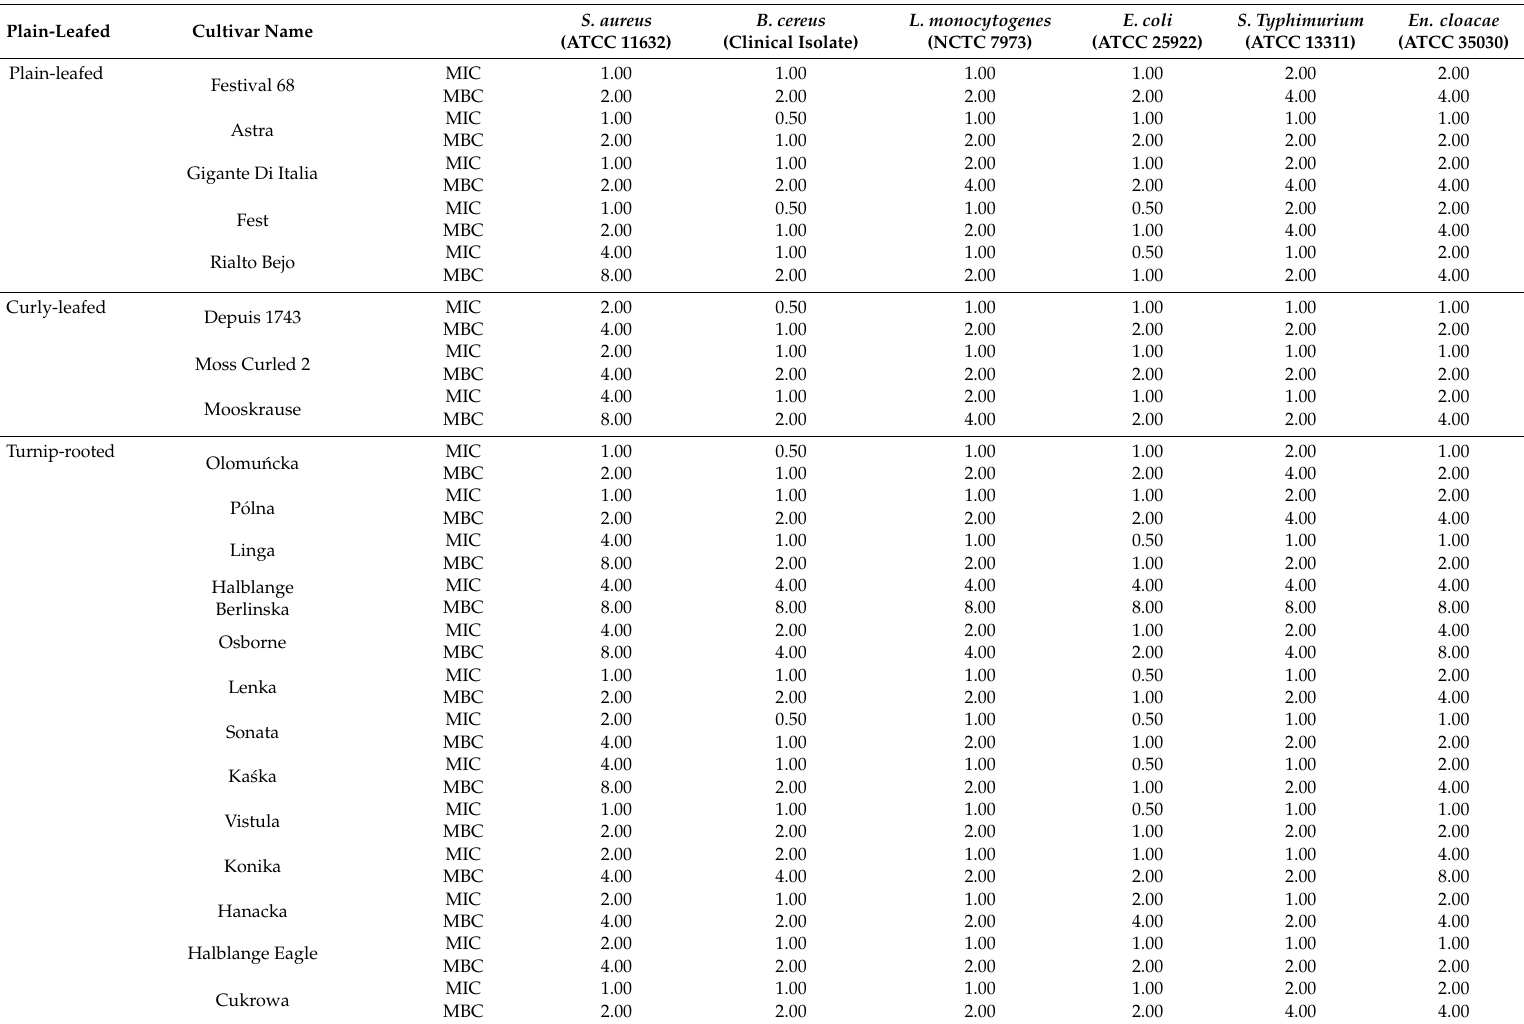
Table 4. Antibacterial activity (minimal inhibition concentration (MIC) and minimal bactericidal concentration (MBC) mg / mL) of parsley leaves’ hydroethanolic